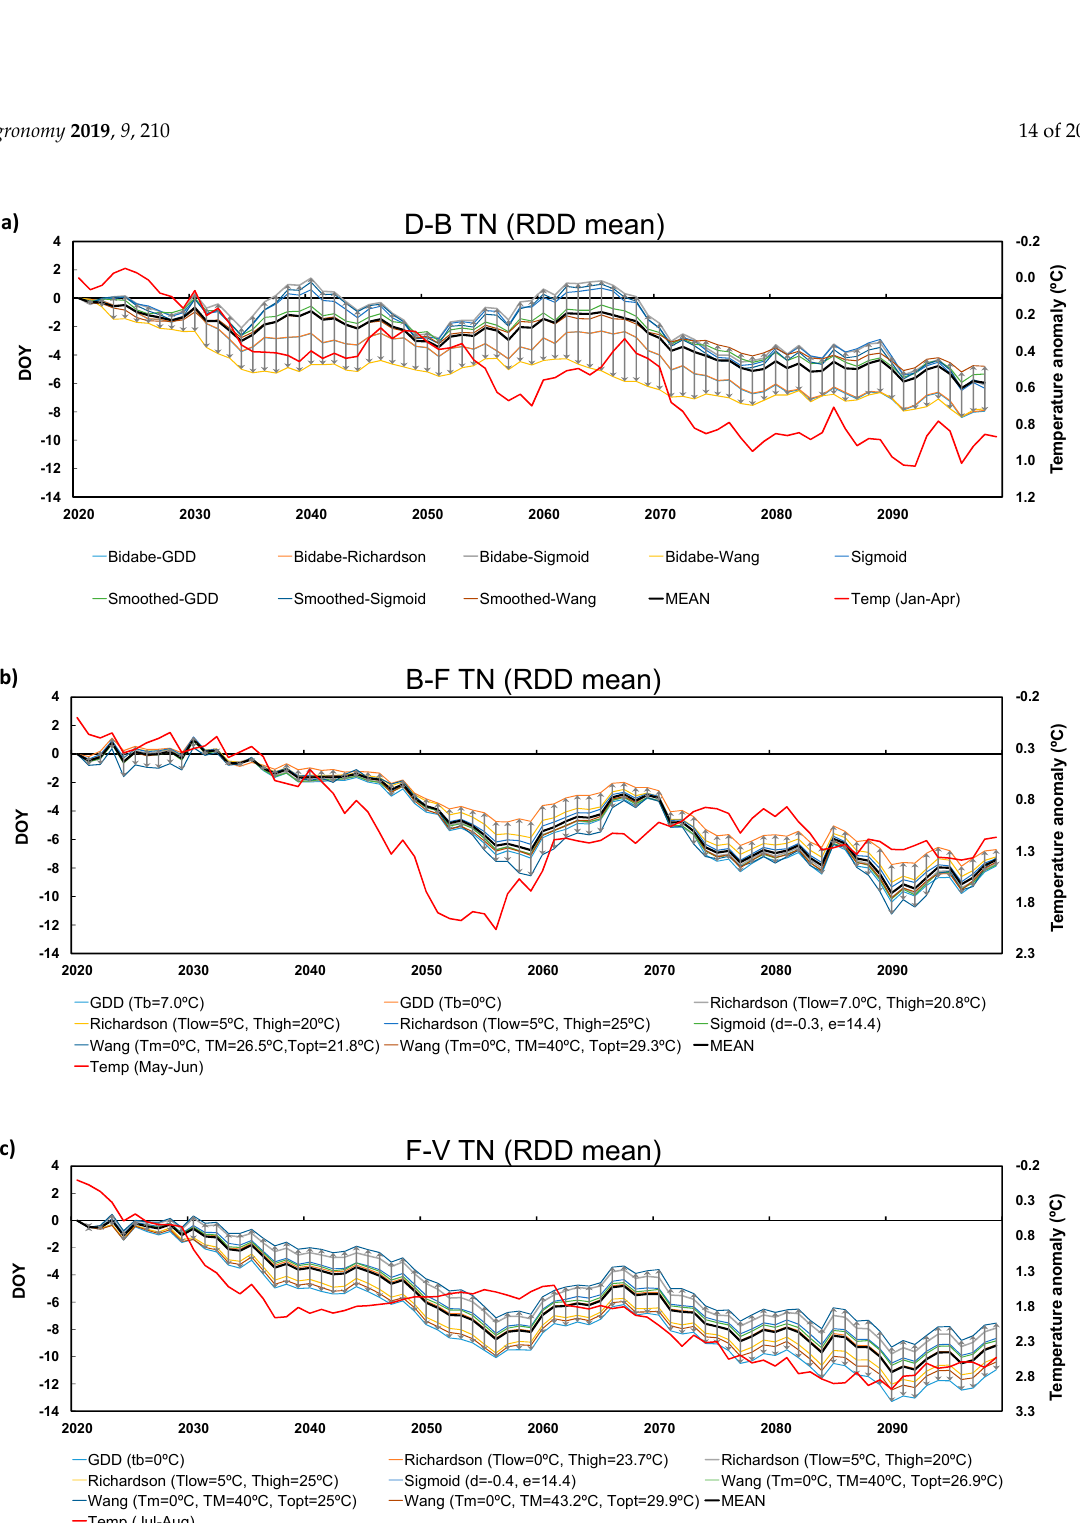
Figure 4. Chronograms (2020–2100, RCP4.5) of the phenological timings (days of the year, DOY) of ( a ) Dormancy–Budburst (D-B); ( b ) Budburst–Flowering (B-F) and ( c ) Flowering–Veraison (F-V), and for cv. Touriga Nacional (TF), obtained from the eight selected models (cf. legends), averaged for all climate models and the 12 sites in the Douro Demarcated Region (DDR) (Figure 1). The average maximum–minimum ranges for each phenophase (among the di ff erent phenology models) are also pointed out (values in days within boxes in the right-upper corner of each panel). The red curves correspondtothe( a )January–April, ( b )May–June, and( c )July–Augustmeantemperatures(temperature scale